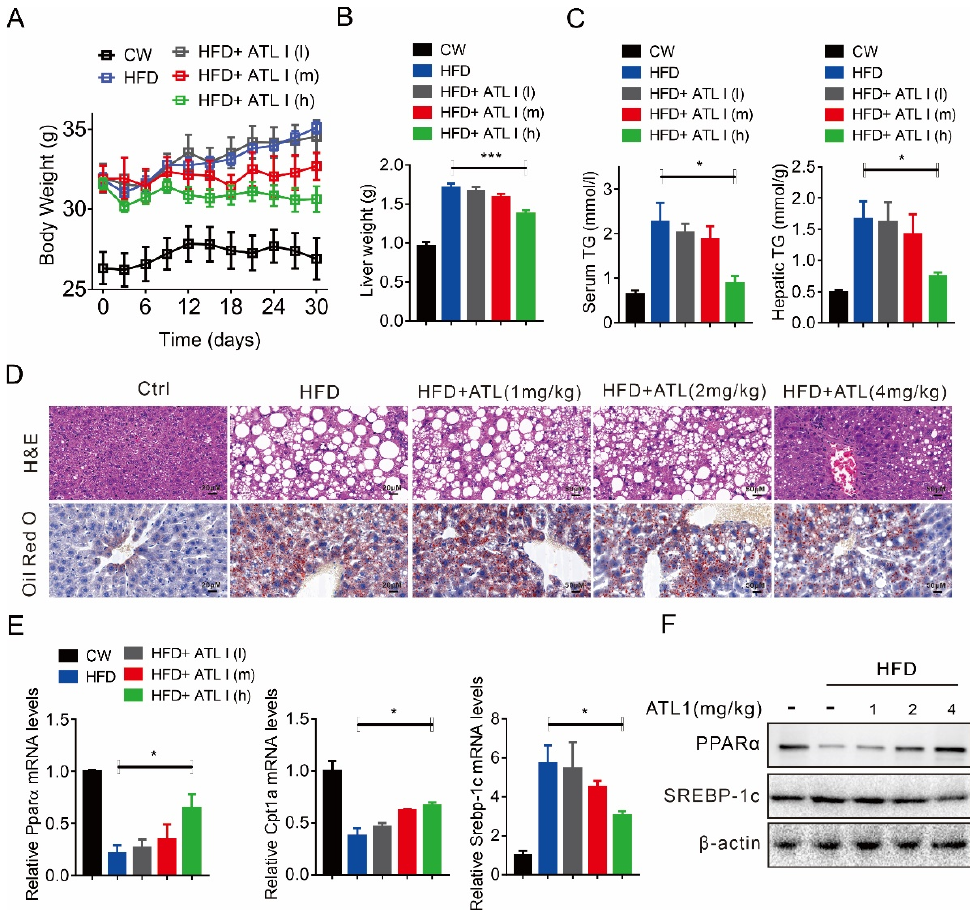
Figure 3. ATL I treatment alleviates HFD-induced fatty liver in mice. ( A ) ATL I treatment effectively decreased the body weight of HFD-induced obese mice in a dosage-dependent manner. ( B ) ATL I treatment significantly decreased the liver weight of HFD-induced obese mice. ( C ) ATL I treatment effectively alleviated HFD-induced elevation of TG contents in serum and liver of HFD-induced obese mice. ( D ) H&E and oil red O staining data indicated an improvement of fatty liver phenotype and lipid accumulation in HFD-induced obese mice after ATL I treatment. ( E , F ) ATL I treatment effectively attenuated the mRNA ( E ) and protein ( F ) levels of genes related to lipid metabolism in HFD-induced obese mice. Results are shown as mean ± SEM (n ≥ 4). * p < 0.05, *** p < 0.001 versus the HFD group.